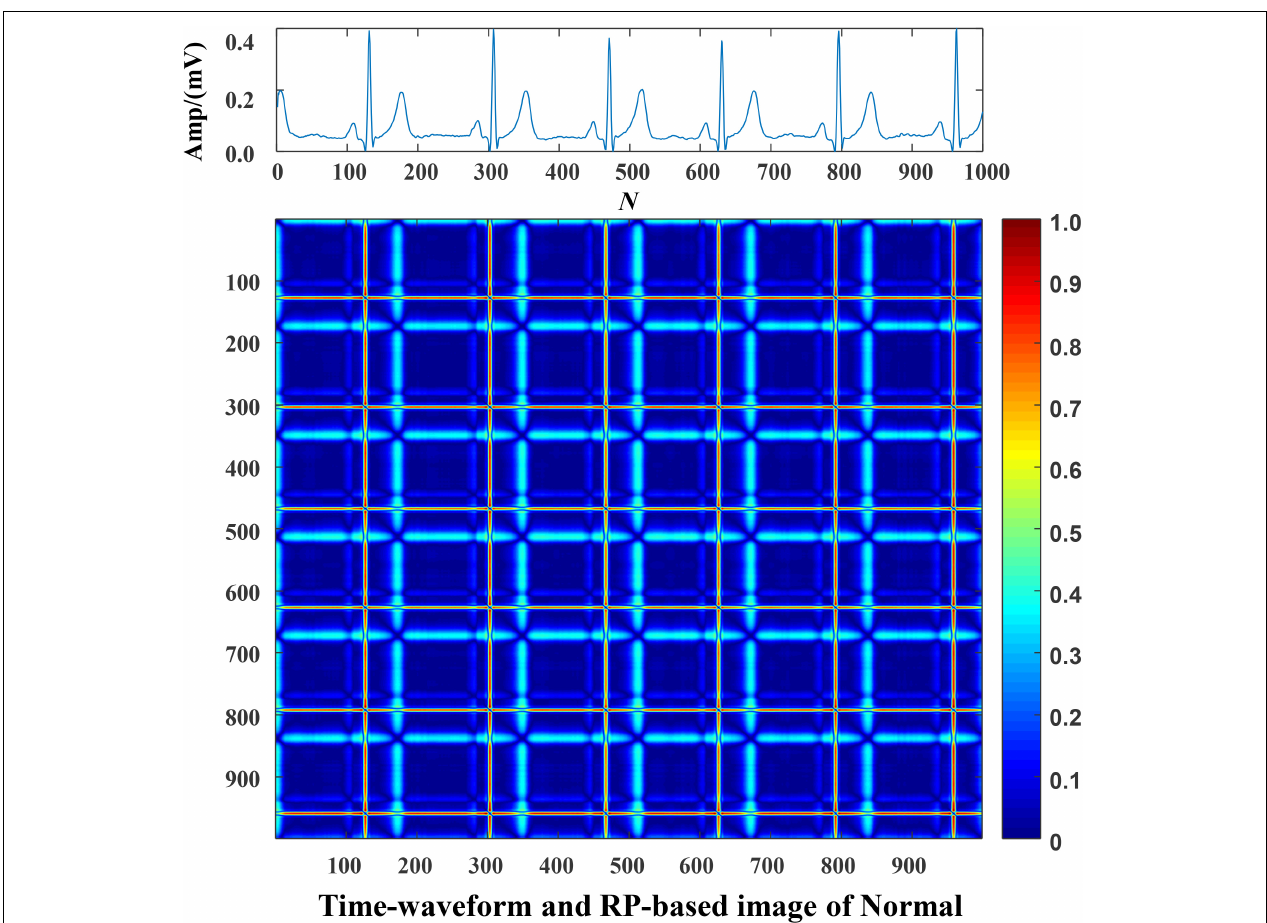
FIGURE 3 | The Normal ECG time waveform and its corresponding RP-based